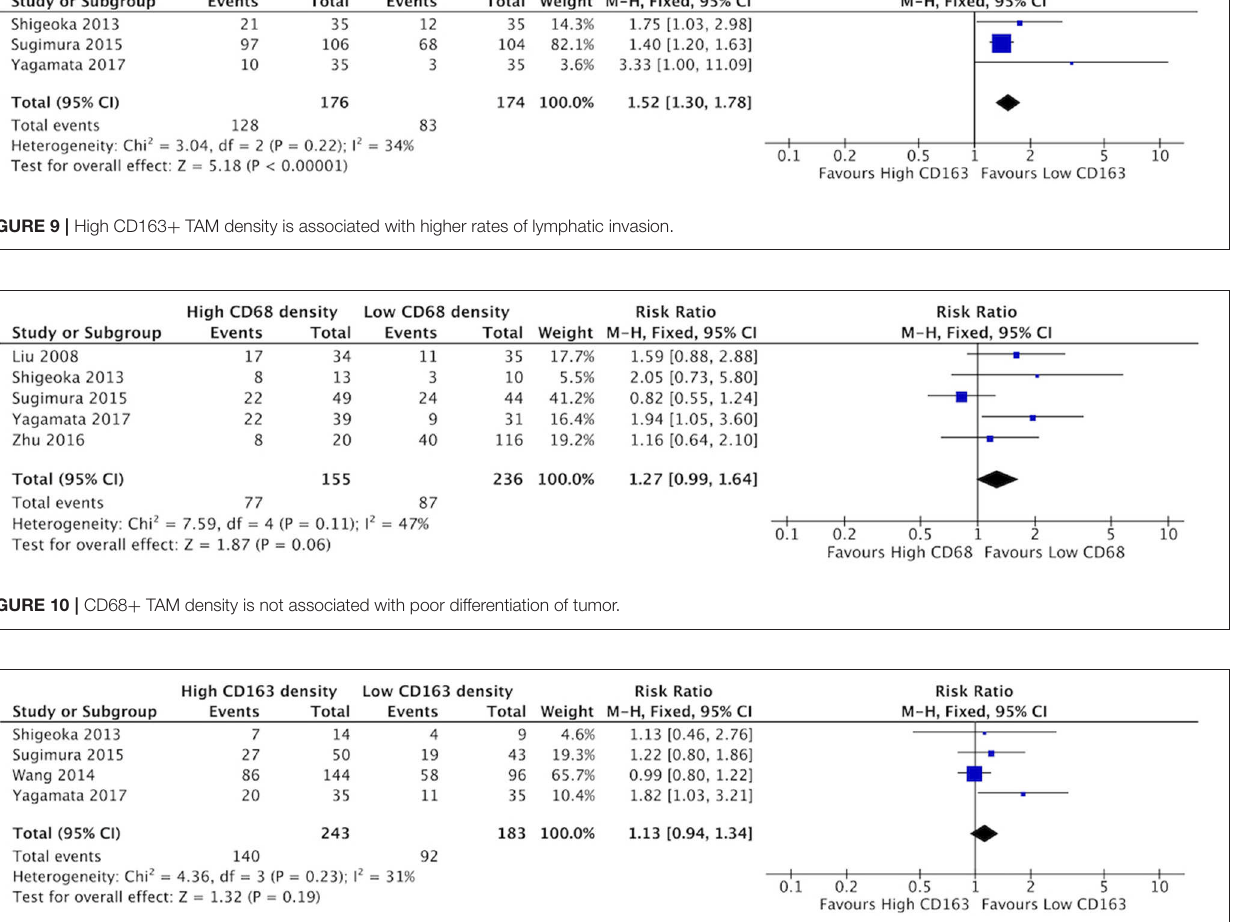
FIGURE 11 | CD163 + TAM density is not associated with poor differentiation of